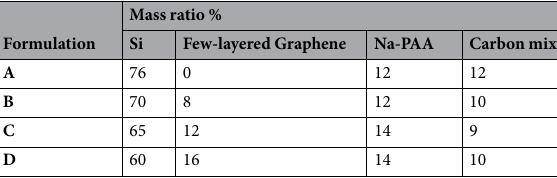
Table 1. Si/graphene formulation matrix.